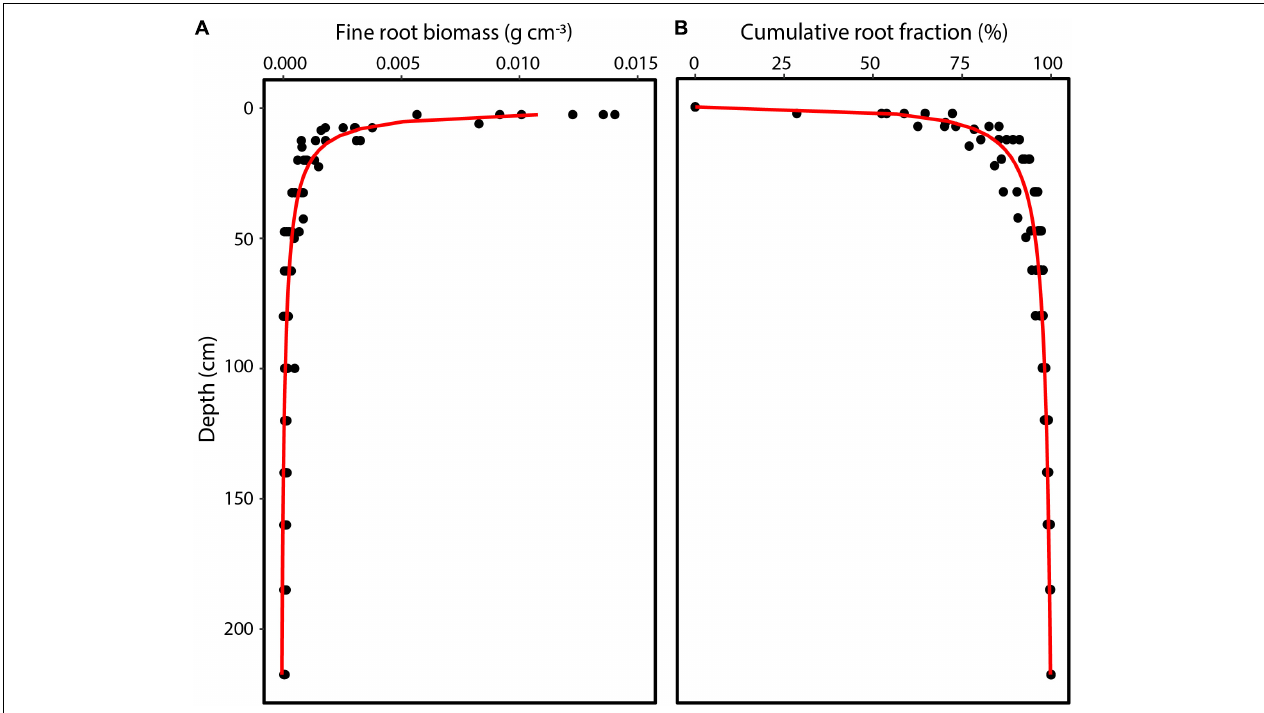
FIGURE 3 | Vertical distribution of (A) fine root biomass and (B) cumulative root fraction in the 0–235 cm profile for an upland soil in a tropical monsoon forest in central Amazonia. Data represent 5–6 replicate